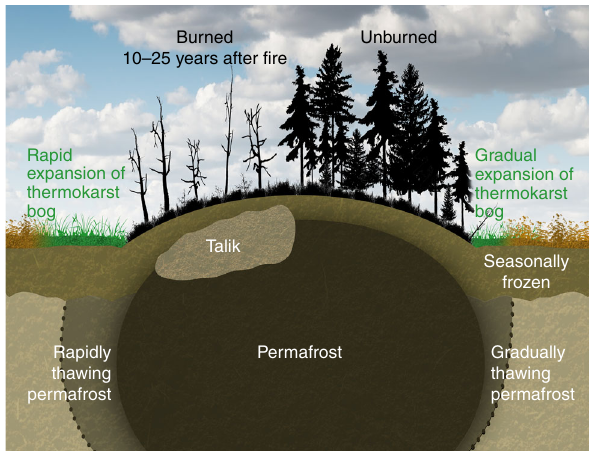
Fig. 2 Simpli fi ed illustration of soil thermal states for peat pro fi les along transects from thermokarst bogs to peat plateaus, within and outside historical burn areas. Taliks are continuously thawed soil layers between the permafrost and the seasonally